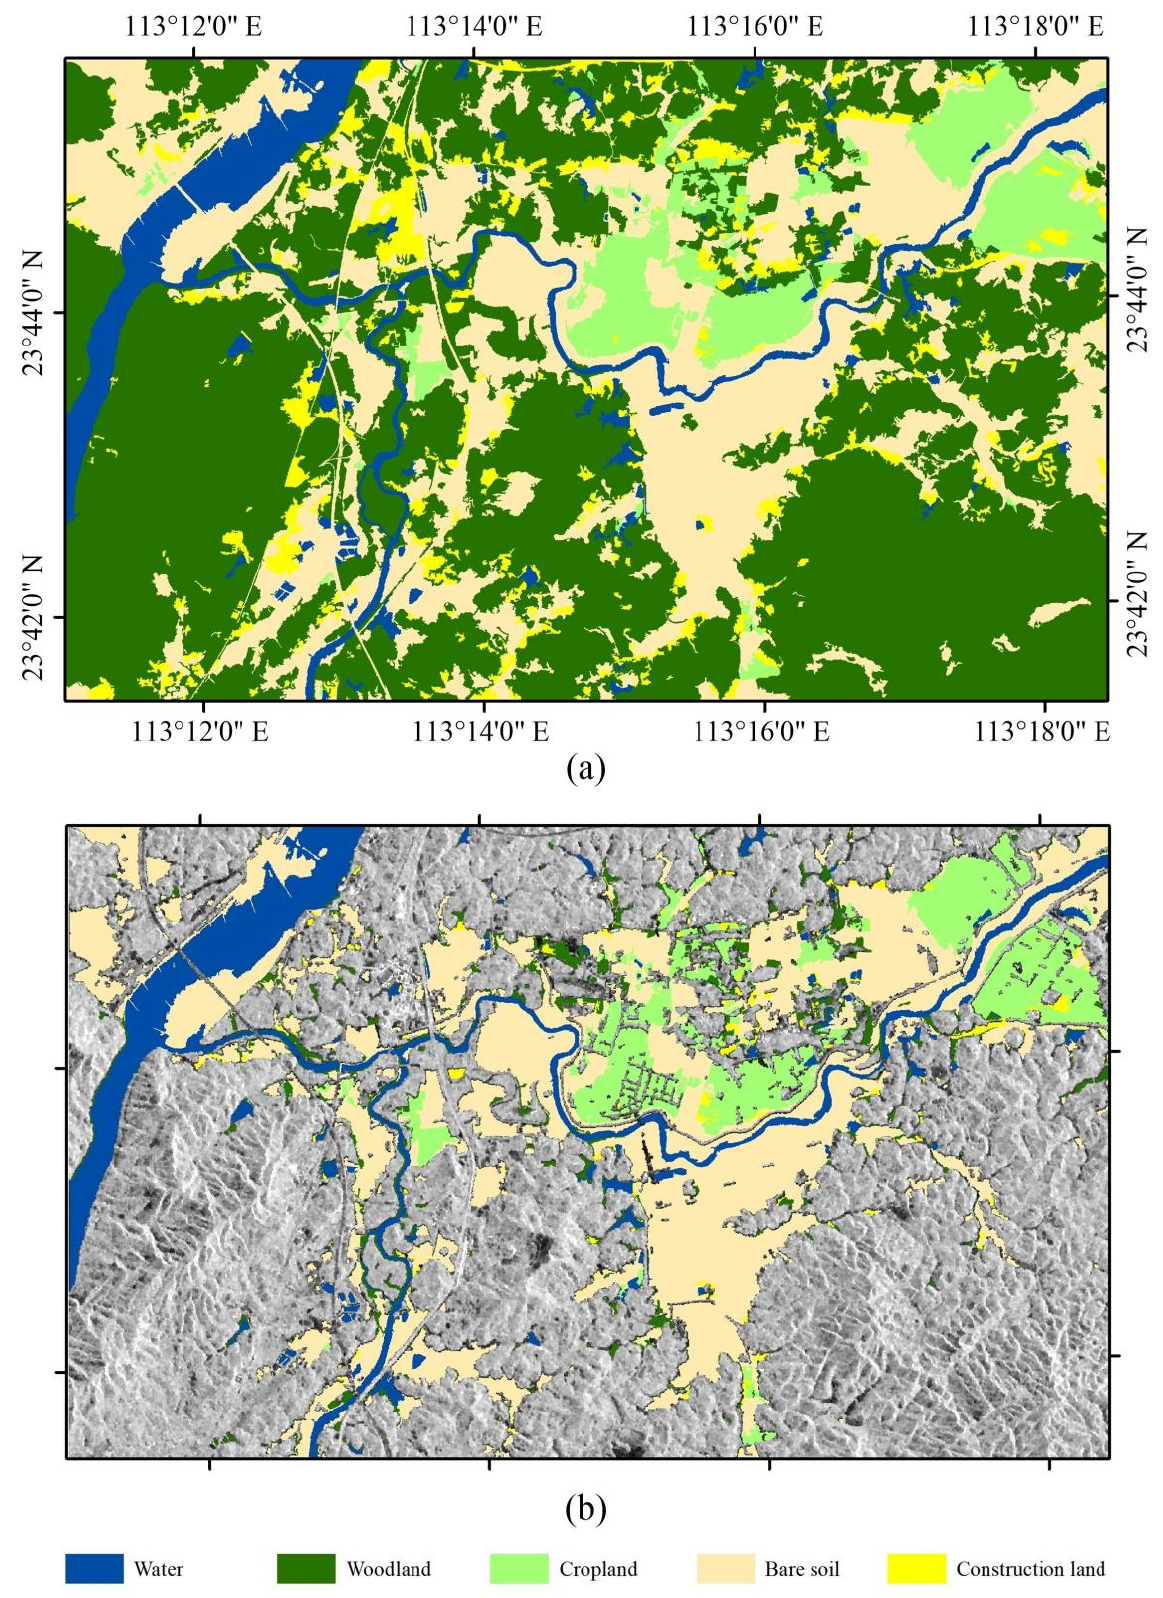
Figure 11. ( a ) The OSA-CNN classi fi cation result in Pajiang. ( b ) The fl ood inundation map in Pajiang.